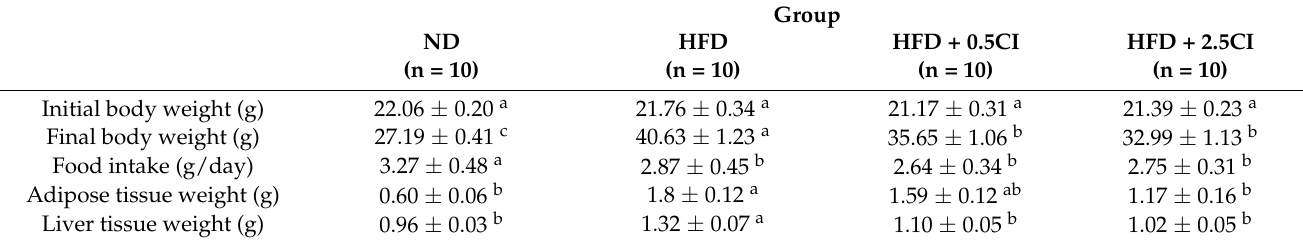
Table 3. Effects on food intake, body, and tissue